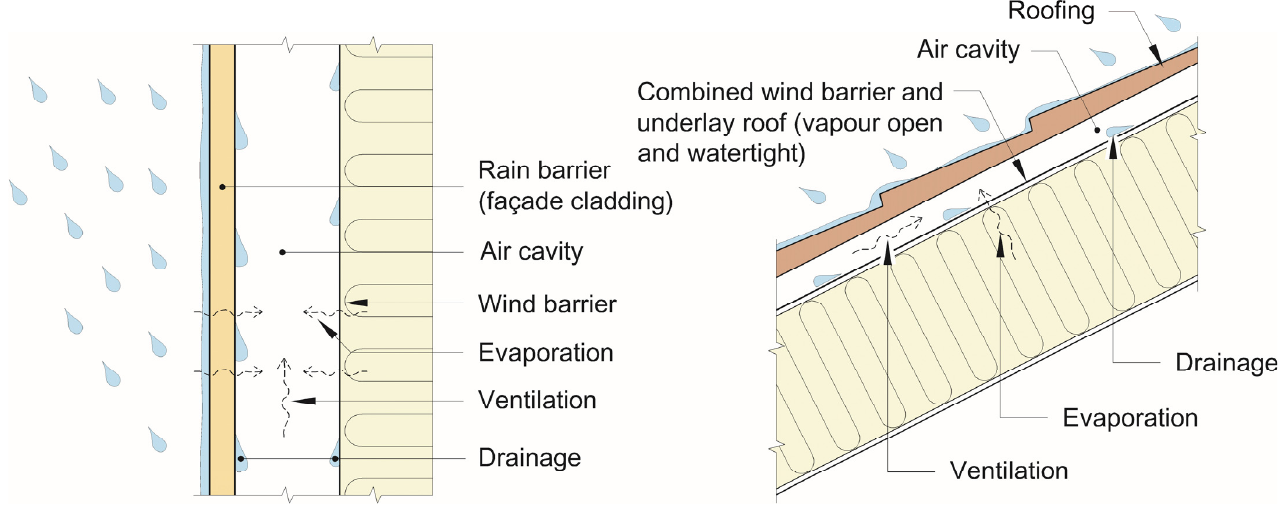
Figure 2. Illustration of the principle of two-stage weatherproofing for a façade ( left ) and a roof ( right ). Reprinted with permission from Refs. [10,11].